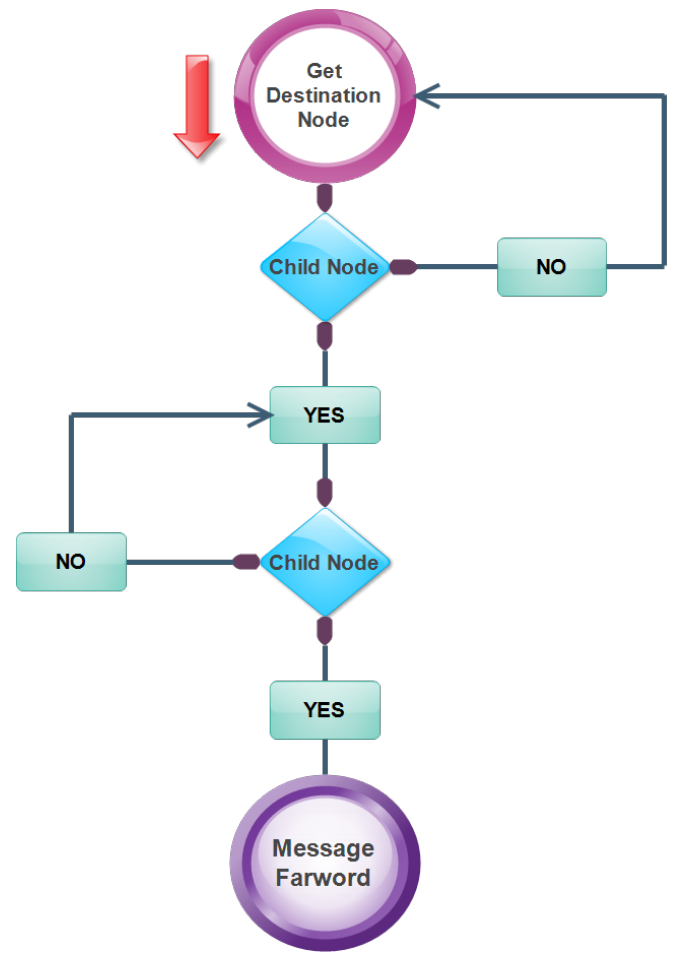
Figure 10. The PKI like protocol for